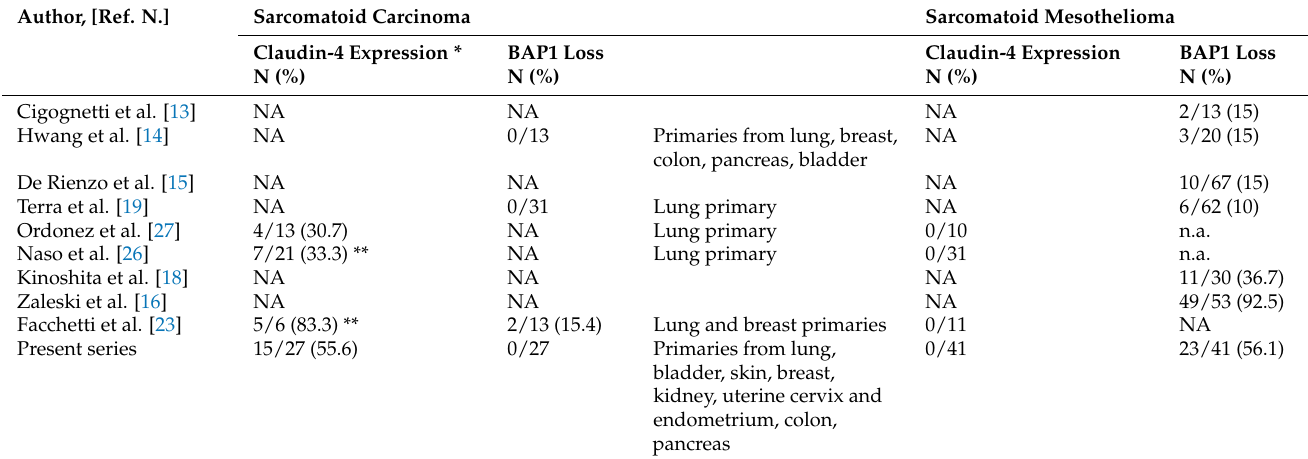
Table 4. Literature review on the BAP1 loss and the Claudin-4 expression in sarcomatoid carcinomas. Legend : NA, not assessed; Ref. N.: reference